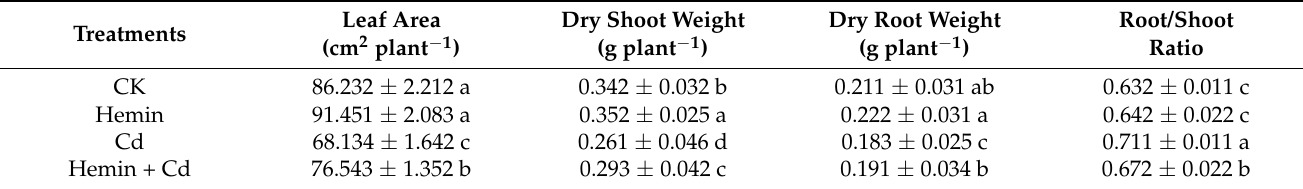
Table 1. Effects of hemin on leaf area, dry shoot weight, dry root weight, and the root/shoot ratio under Cd stress.